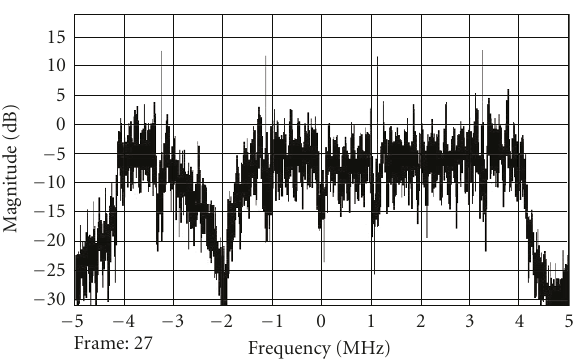
Figure 10: Power spectrum characteristics of the OFDM signal under the frequency-selective fading channel (Eb/No = 10 dB).